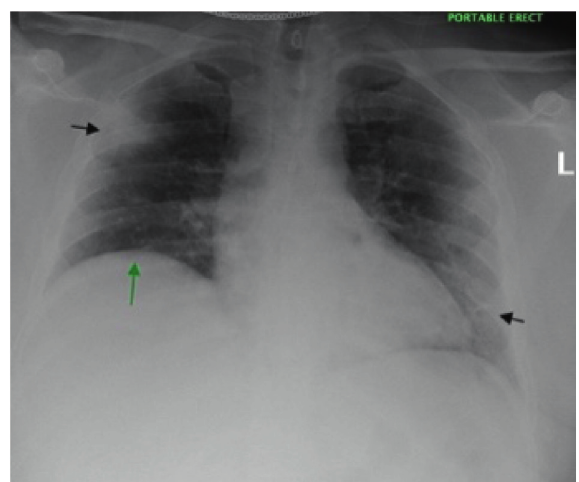
Figure 1: A portable chest radiograph on day 1 of presentation shows bilateral patchy infiltrates (black arrows) in the right upper lung and left lower lung, with mild elevation of the right hemi- diaphragm (green arrows).